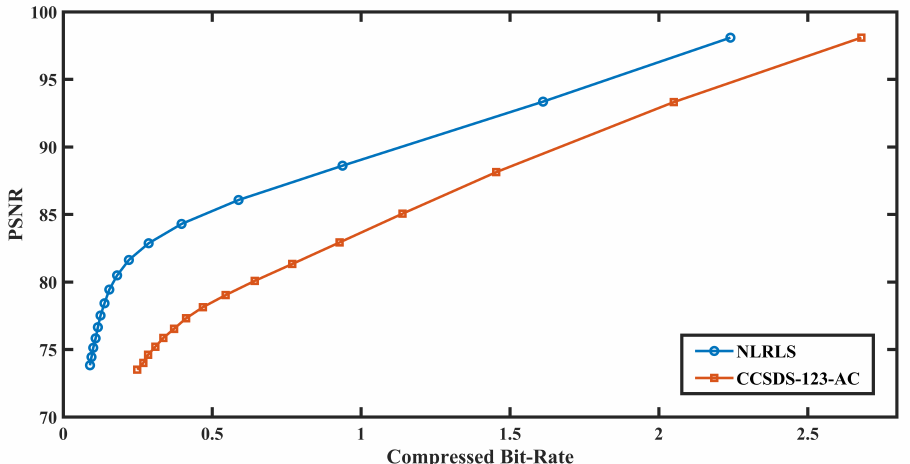
Figure 6. The PSNR performance of the proposed method compared to CCSDS-123-AC.